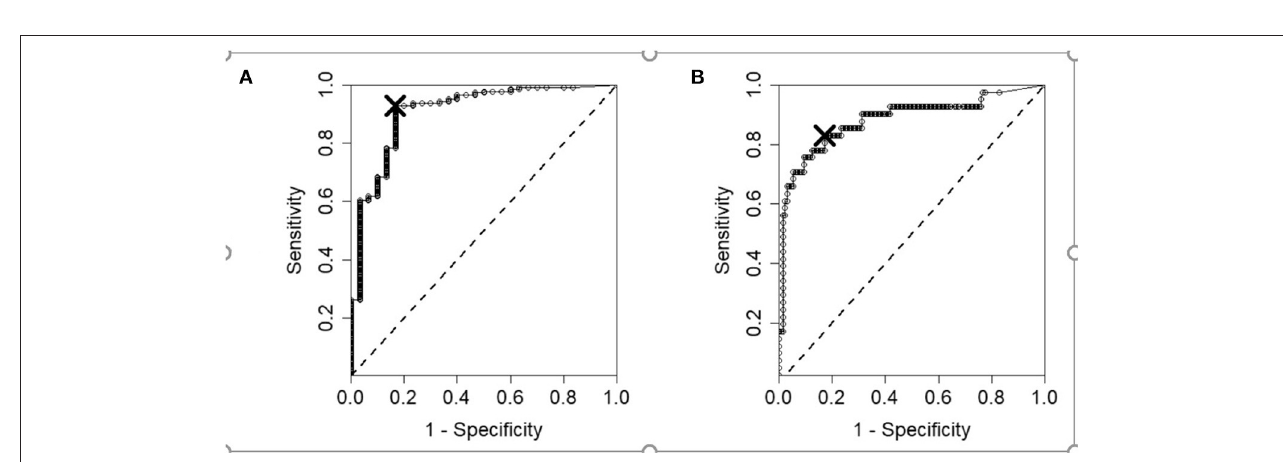
FIGURE 1 | ROC curves showing the results of the health alert model for the (A) old and (B) young/middle-aged dogs. The cut-offs chosen by the top left corner method are shown as large crosses.